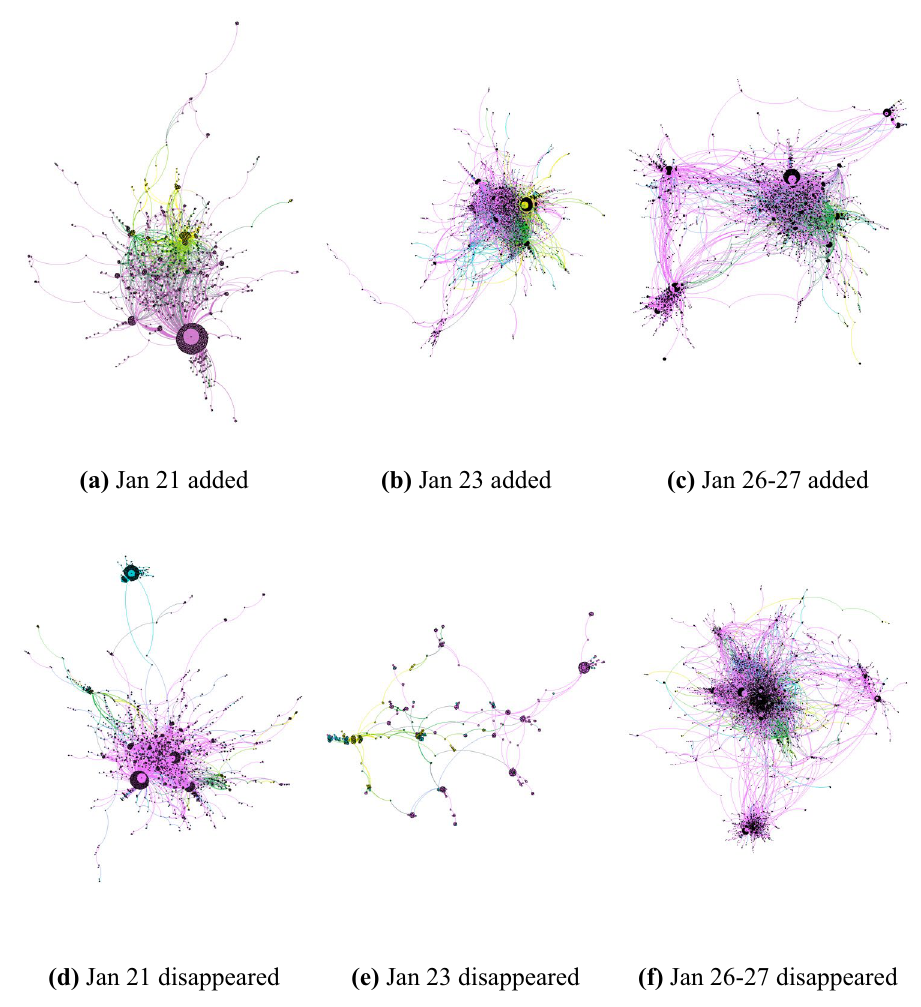
Figure 2. Network visualizations of the largest connected component of the added connections (top) and disappeared connections (bottom) in social interaction networks for each of the three internet outage events in Venezuela by language (Spanish—purple, English—yellow, bilingual—green, other—teal). We find that after every network outage, the added graph has longer mean shortest paths (3.342, 3.918, and 4.587), more connected components (158, 661, and 922), and a larger number of communities (205, 734, and 870), compared with the previous